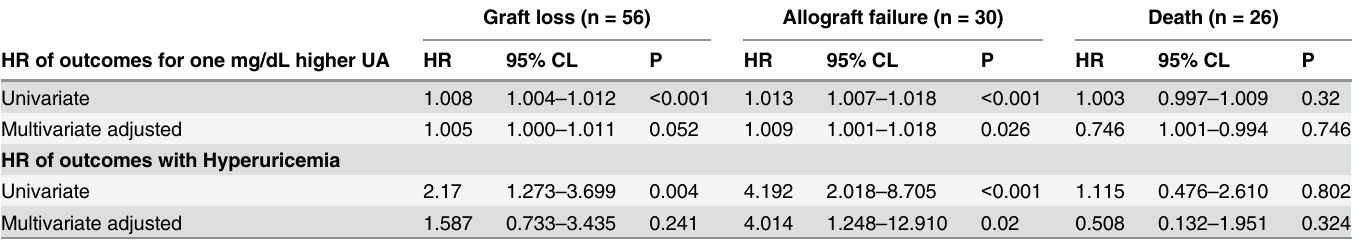
Table 8. Hazard ratios of graft loss, graft failure, and death with UA/hyperuricemia in Cox proportional hazard models. Graft loss includes allograft failure and death; multivariate variables include: age, gender, BMI, HLA mismatch, introduction regimen, immunosuppressive agent protocol, diabetic melli- tus, dialysis type, DGF, infection and acute rejection episode; abbreviations as previous tables; HR, hazard